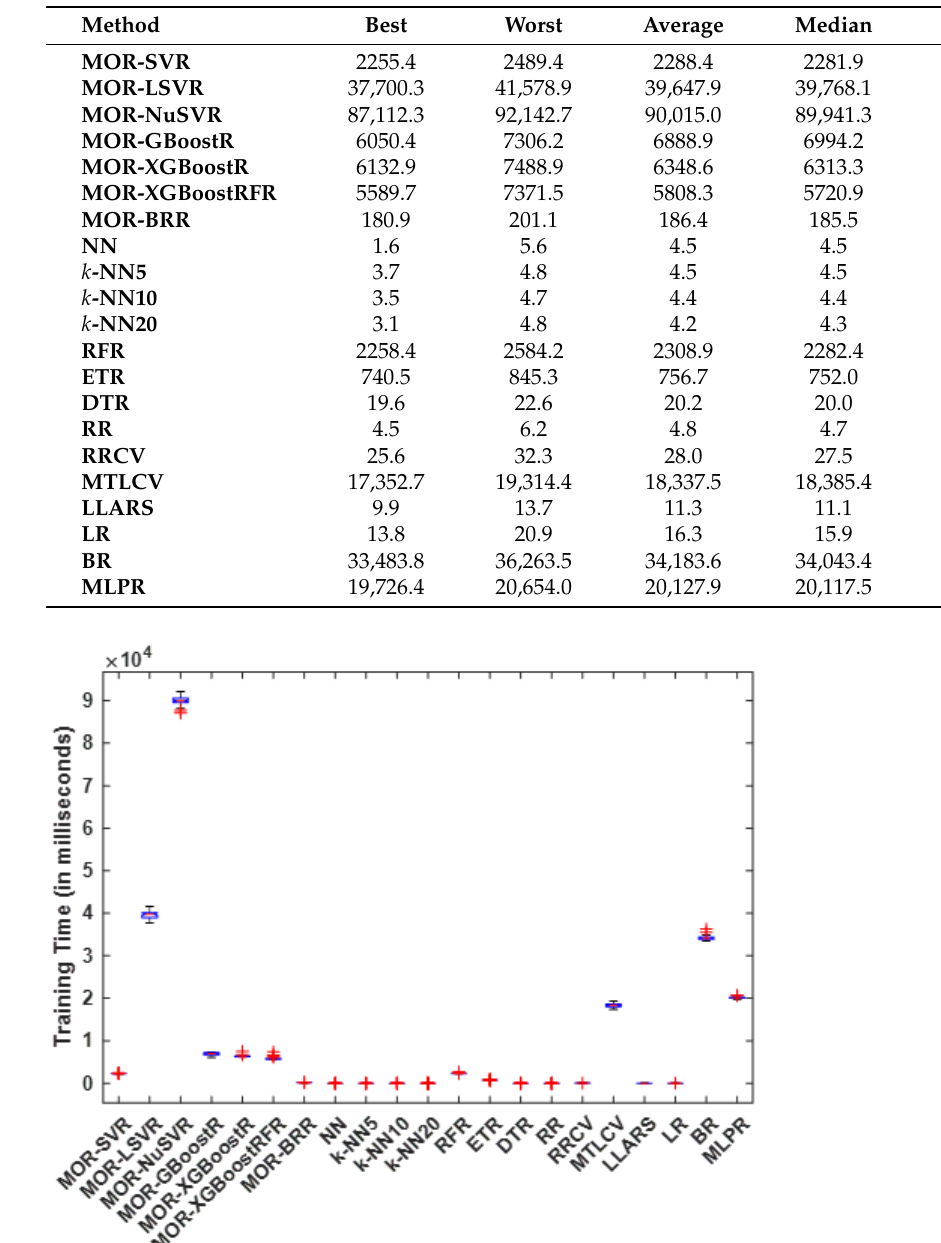
Table 5. Training time (in milliseconds (ms)) for all methods over 50 statistical runs (the second stage).